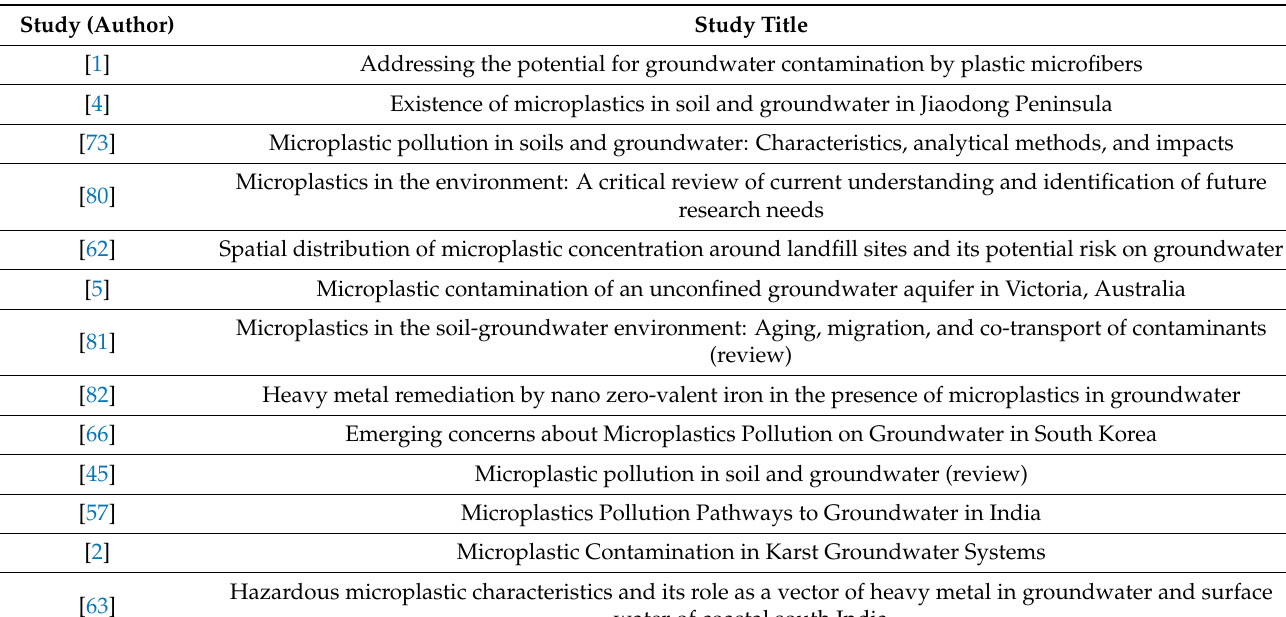
Table 1. Recent research on microplastics in groundwater and soil.